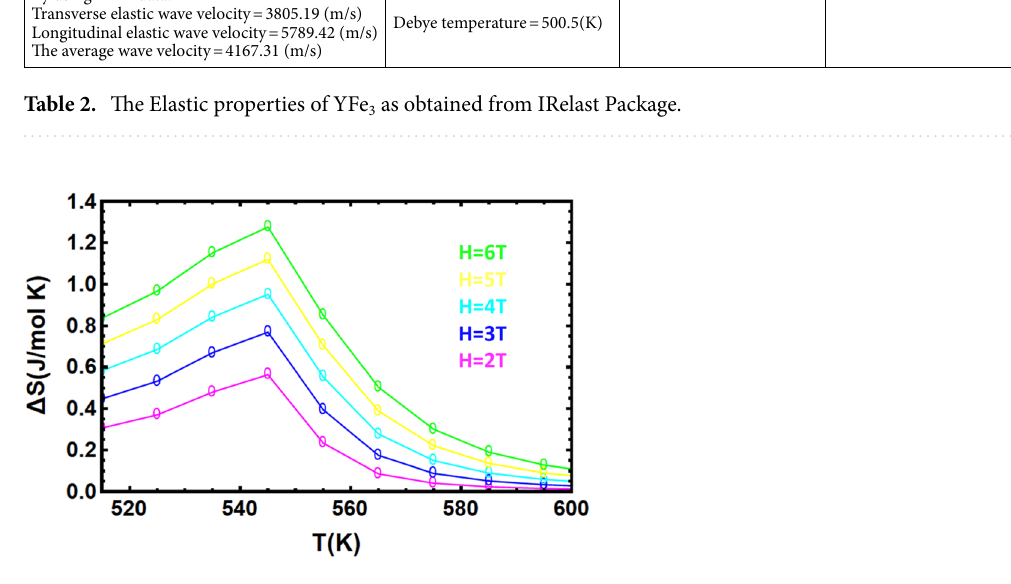
Figure 10. Temperature dependence of isothermal change in entropy for YFe 3 in fields: 2, 3, 4, 5 and 6